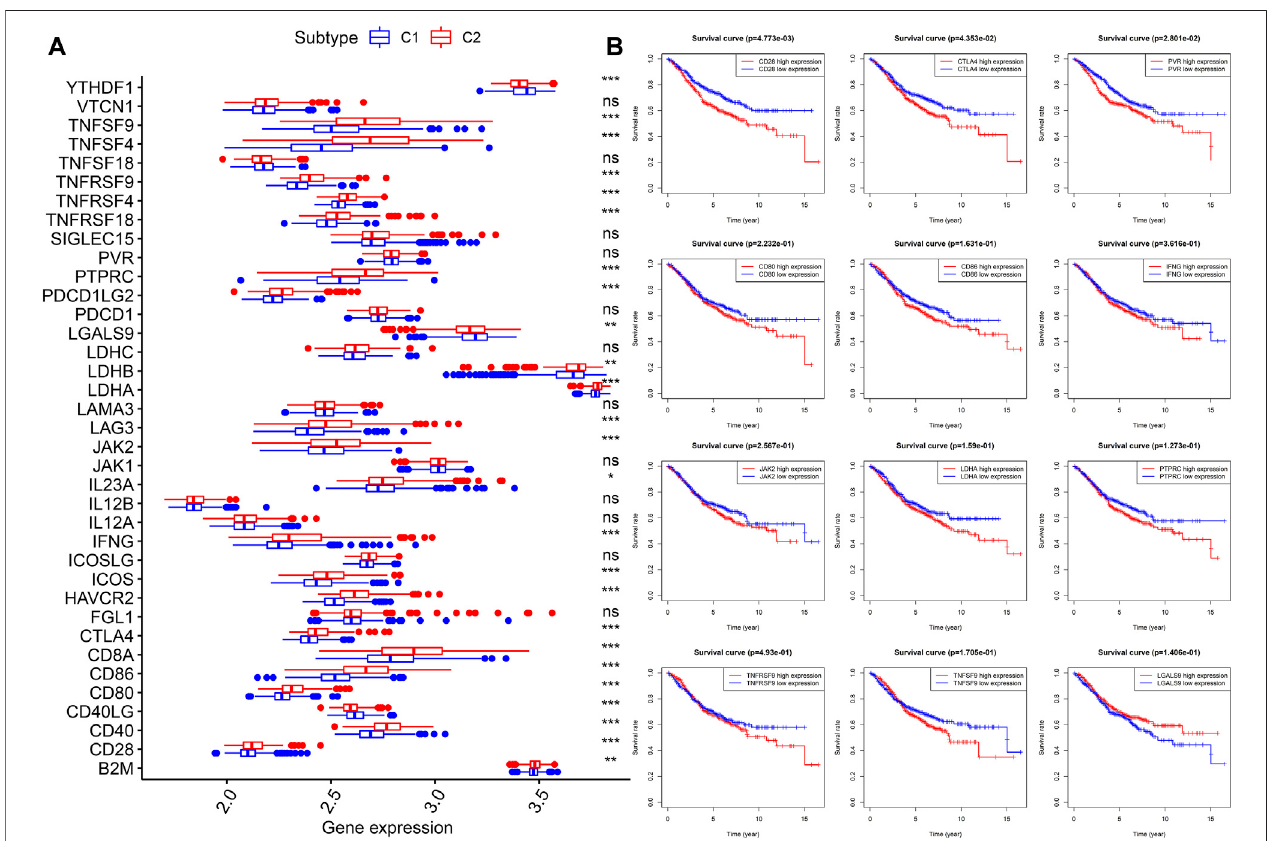
FIGURE5| ExpressionlevelsandprognosticvaluesofICGsintwomolecularsubtypes. (A) Differentialexpressionanalysisof37ICGs. (B) Kaplan – Meieranalysisof ICGs. ICGs, immune checkpoint genes.